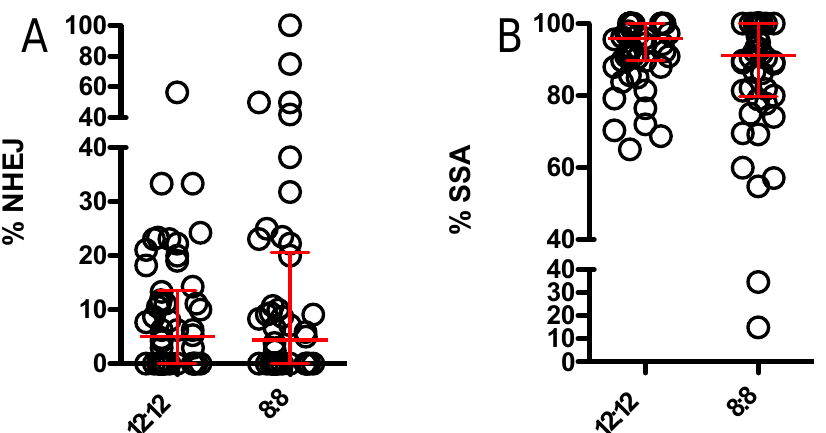
tained under 8:8 L:D (n = 20) ( p > 0.58). Data used to construct this figure are available in Table S4.